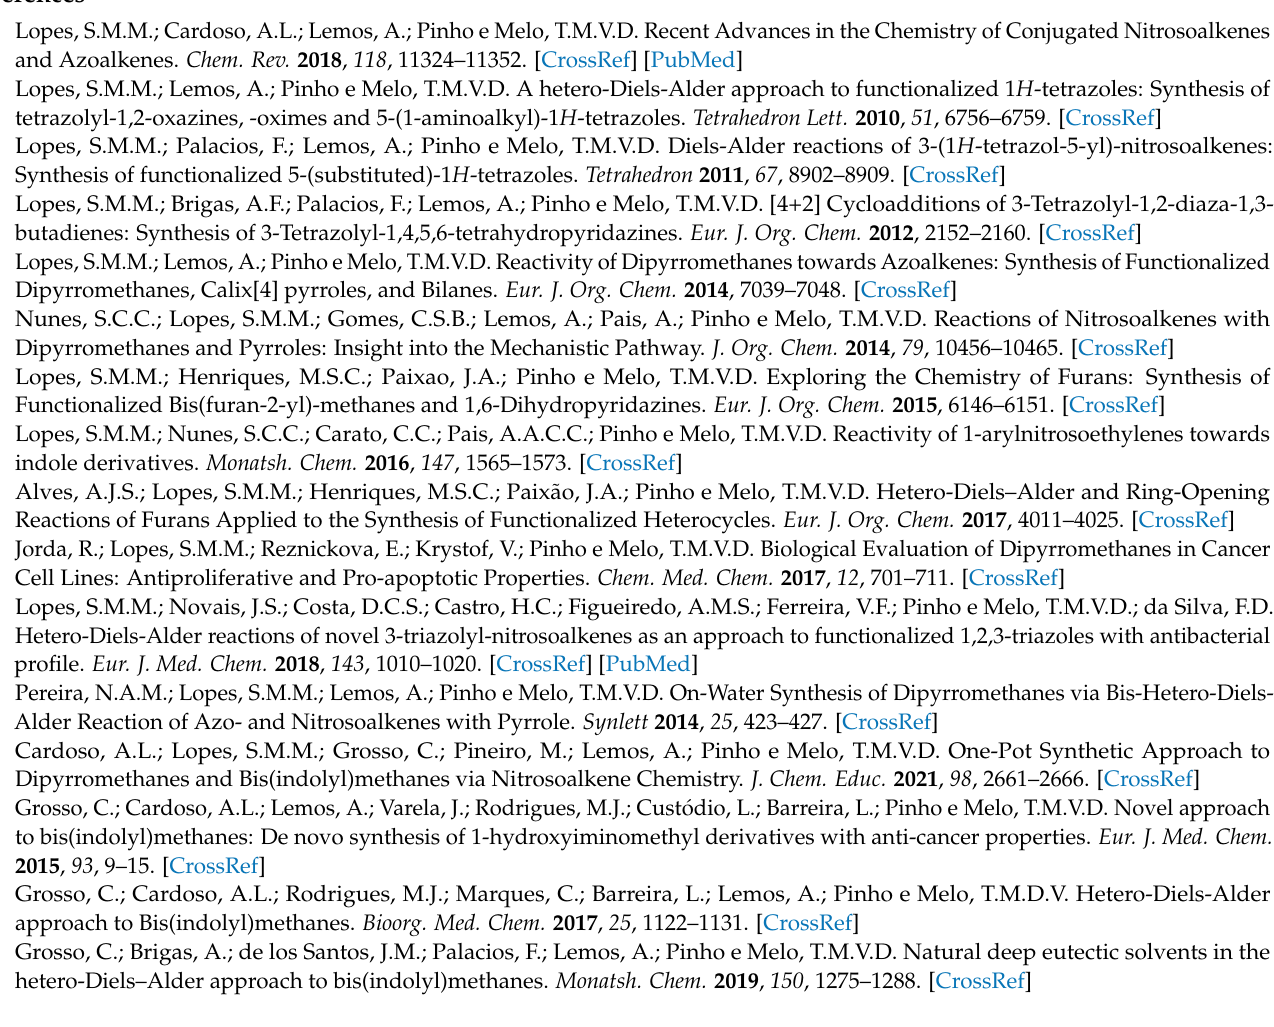
Supplementary Materials: Copies of 1 H and 13 C NMR spectra (Figure S1), IR spectra (Figure S2), HRMS (Figure S3) and crystallographic data (Figure S4 and Tables S1–S5) of compound 7 are